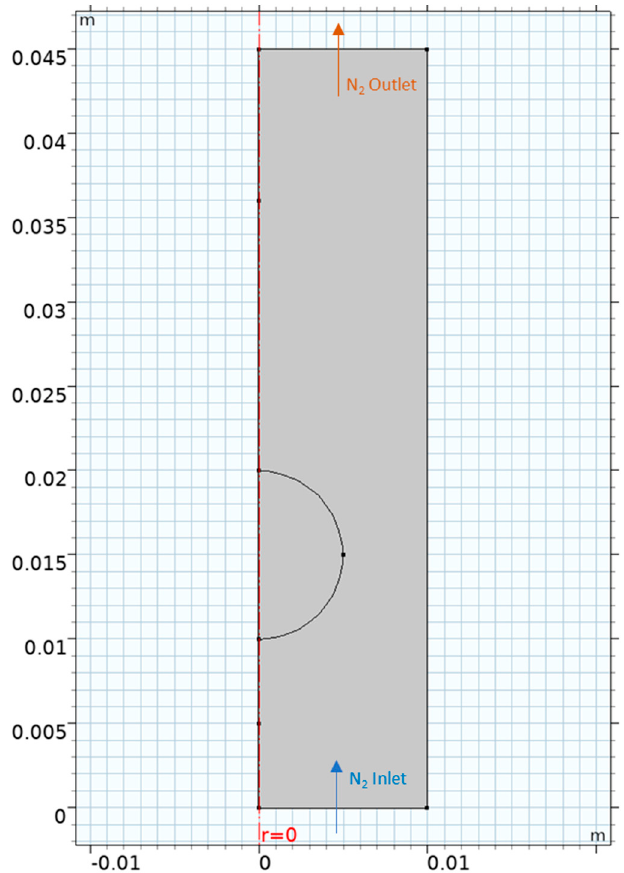
Figure 2. The 2D model geometry of the model with the droplet and the N 2 domain with their inflow and outflow directions. and outflow